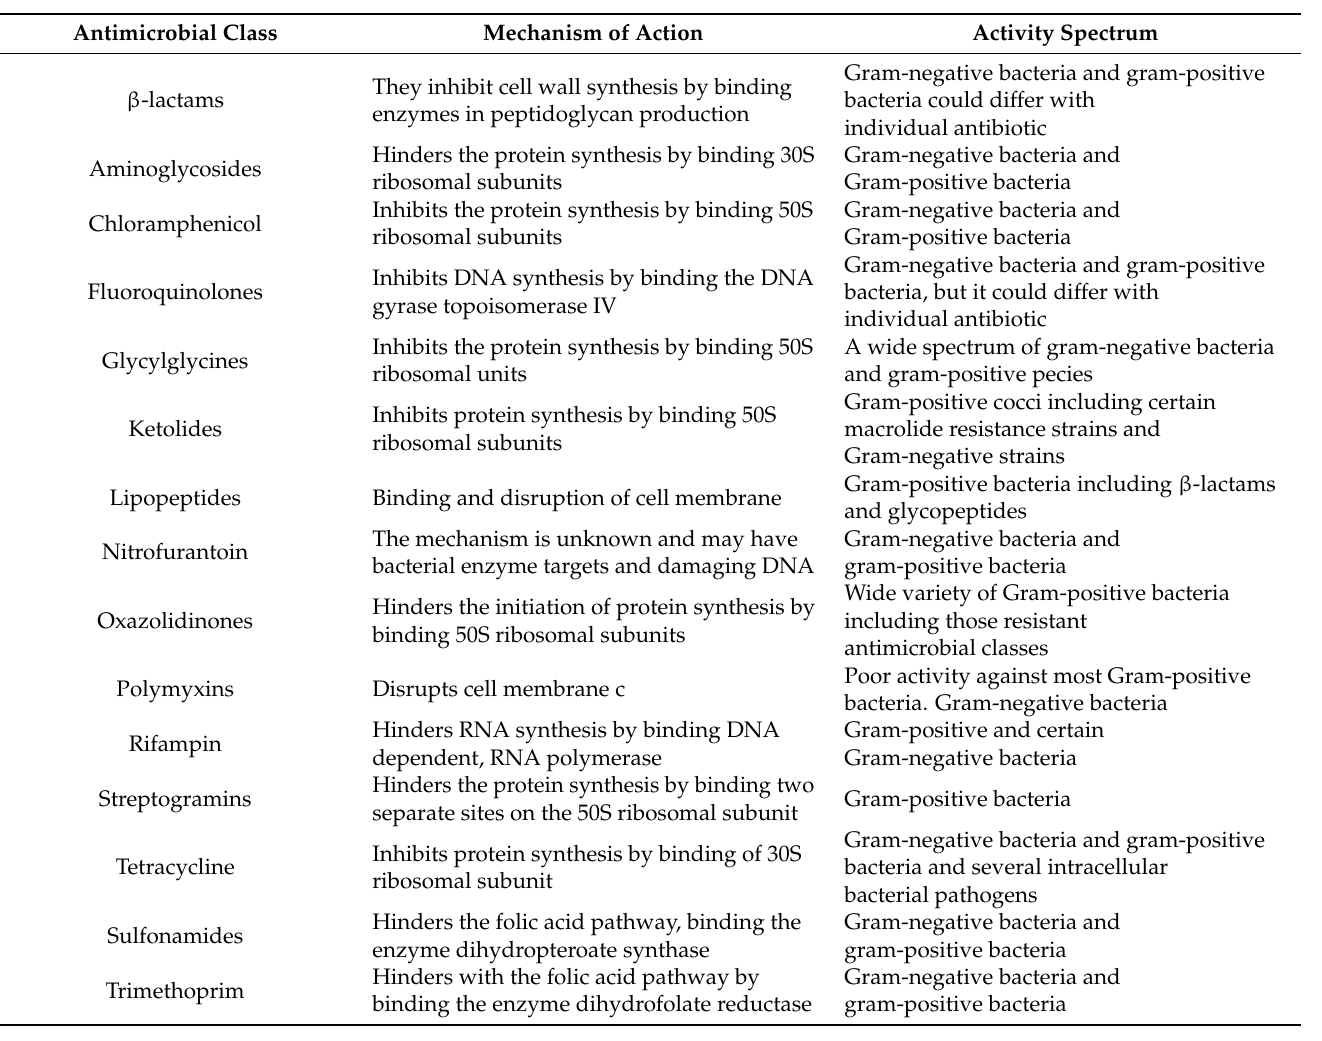
Table 2. Representation of mechanisms of action of antimicrobial agents [25]. Adapted with permis- sion from Ref. [25]. 2014, Dr Patricia